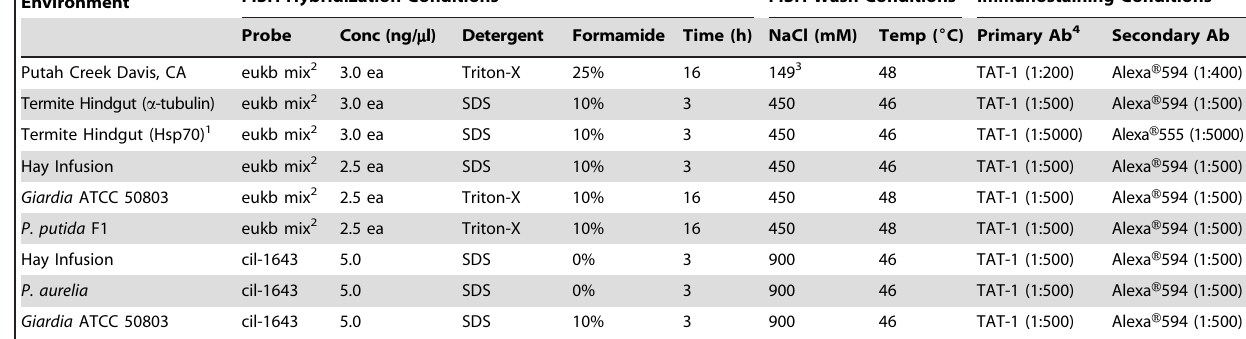
Table 1. Specific conditions for the immunoFISH protocol for each environment or control sample.